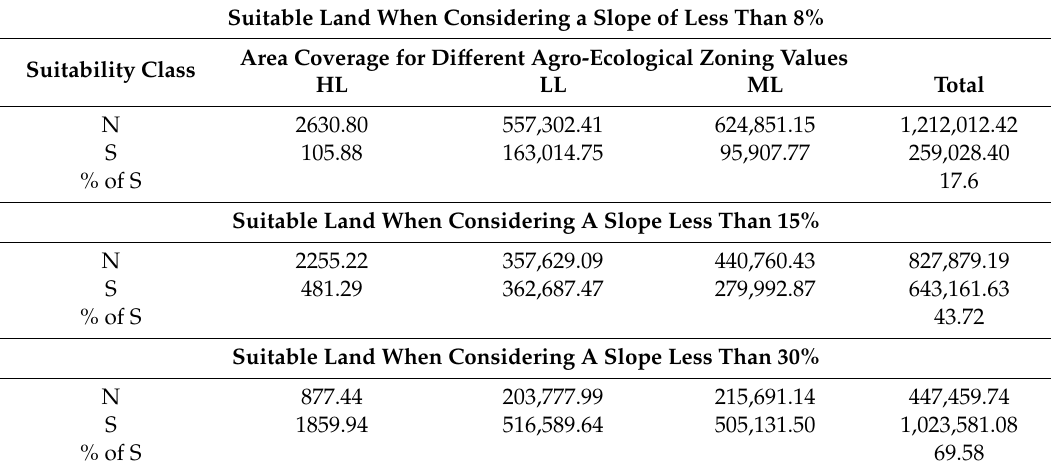
Table 6. Land suitable for surface irrigation with di ff erent slope scenarios. Suitable Land When Considering a Slope of Less Than